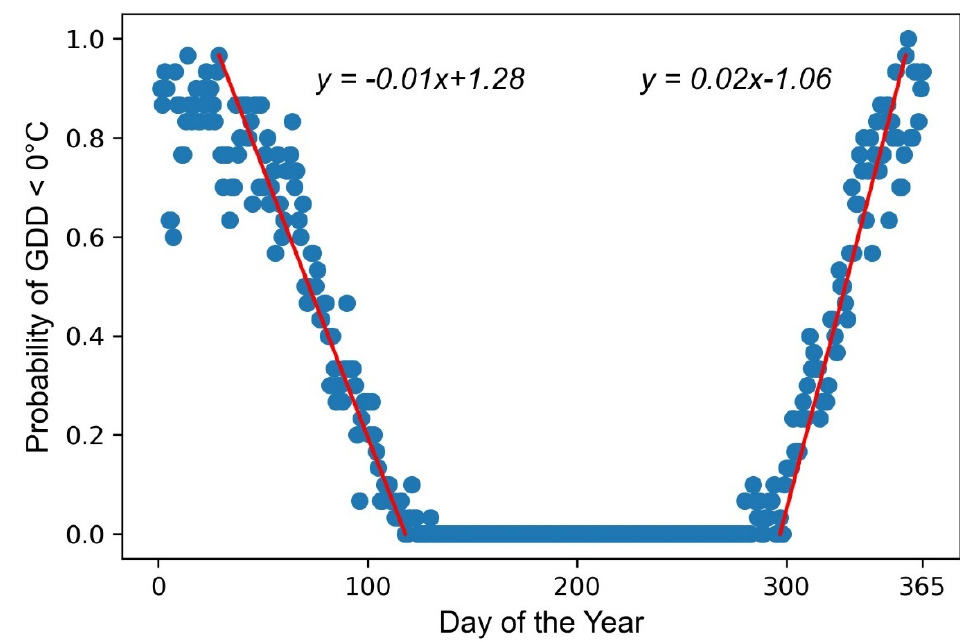
Figure 2. Example of growing degree day (GDD) estimated for alfalfa for Washington County, Kansas. The blue dots represent the GDD of past 30 yrs (1988–2017). The two red lines are the best fit regression line that defines the duration of the growing season.